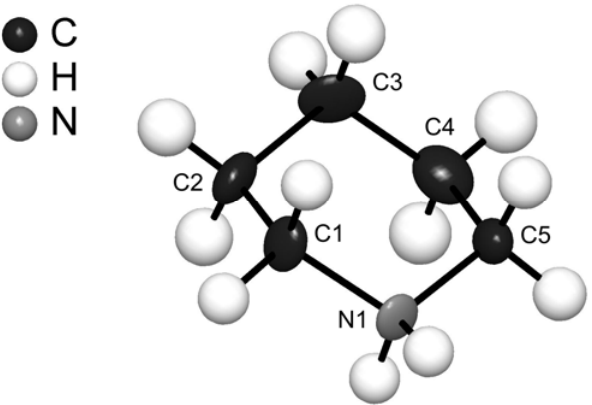
Figure 2. View onto a piperidinium ion of (HPip)Cu are labeled according to Table 2.